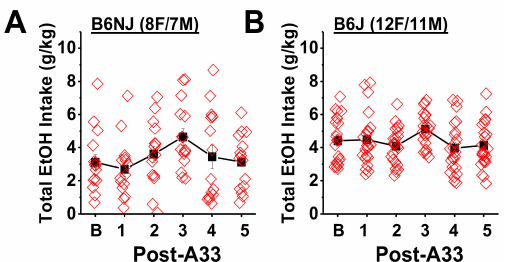
Figure 4. A33 dosing does not produce any carry-over effects the day following injection. Comparison of the average baseline alcohol intake exhibited by ( A ) B6NJ and ( B ) B6J mice and the total alcohol intake exhibited the day following each A33 injection (Post-A33). The data represent the mean ± SEM of the number of mice indicated in parentheses, as well as the individual data points for each drinking day.